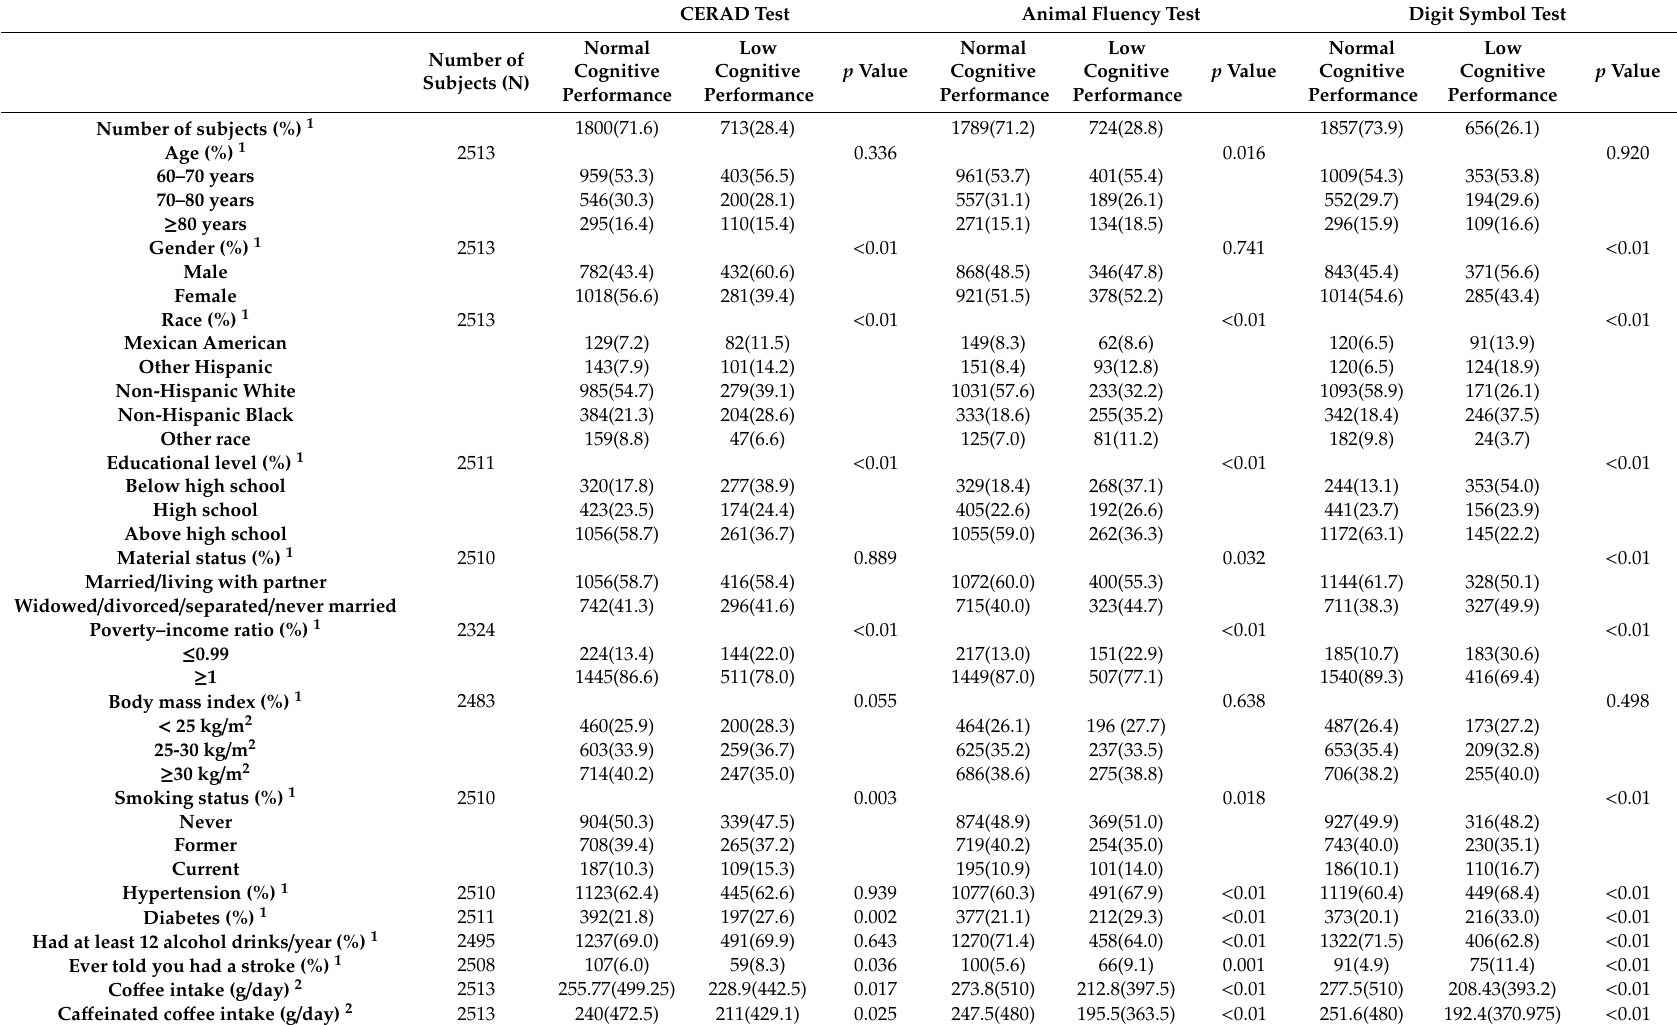
Table 1. Characteristics of the study population, National Health and Nutrition Examination Survey (NHANES) 2011–2014 (N = 2513).